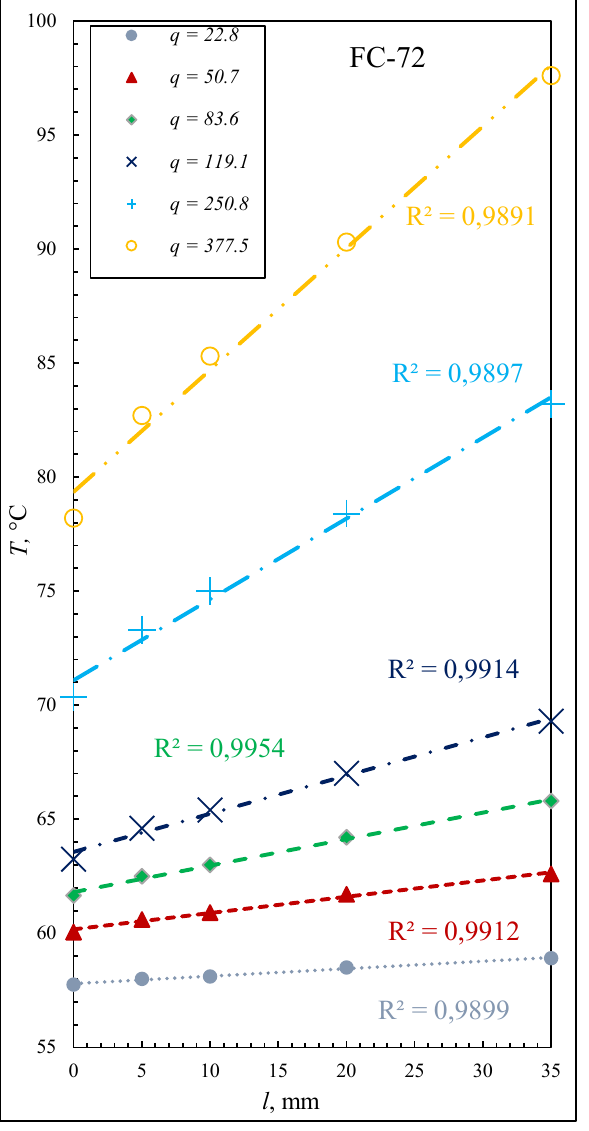
Fig. 6. Temperature vs. thermocouple location in the heating cylinder, MCC-F-4.2-0.5-2, boiling FC-72.